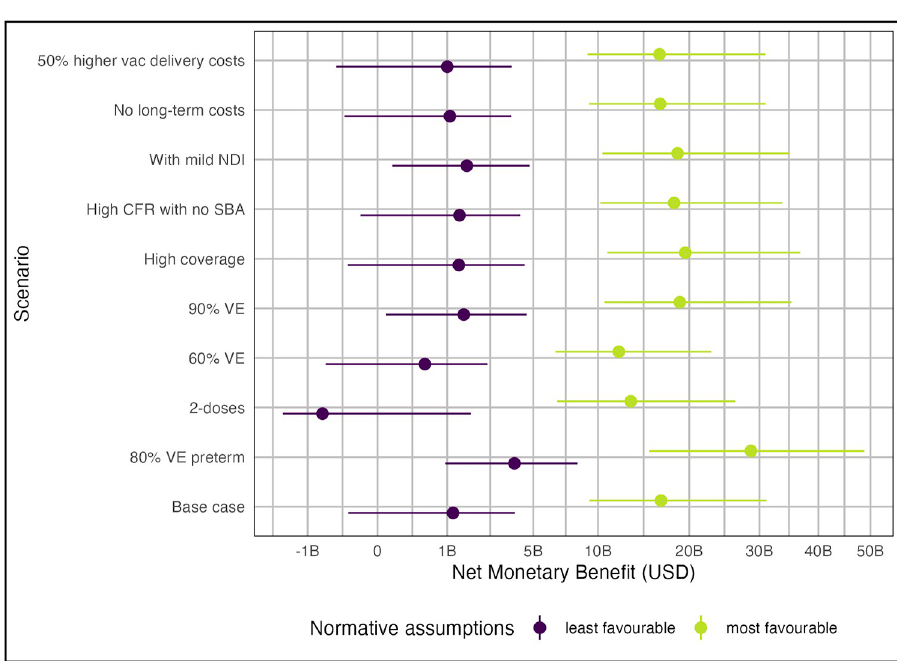
Fig 4. Annual global NMB of GBS maternal vaccination under most favourable and least favourable normative assumptions (see Table 1) for different vaccination scenarios. Points show median estimates and lines show 95% URs. Least favourable normative assumptions were the use of an empirical CET, 3% discounting of QALYs, and exclusion of stillbirth QALYs. Most favourable assumptions were the use of 1 × GDP per capita CETs, 0% discounting of QALYs, and inclusion of stillbirth QALYs. B, Billions; CET, cost-effectiveness threshold; CFR, case fatality risk; GDP, Gross Domestic Product; NDI, neurodevelopmental impairment; QALY, quality-adjusted life year; SBA, skilled birth attendant; VE, vaccine